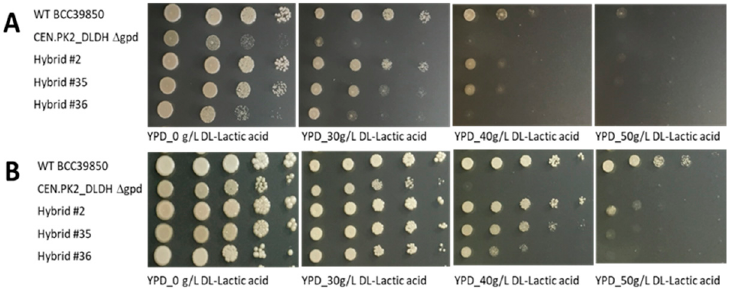
Figure 3. Lactic acid tolerance of S. cerevisiae BCC39850 (wild-type parent), CEN.PK2_DLDH Δ gpd (transgenic parental strain), and progeny hybrid2, hybrid35, and hybrid36. Strains were grown in liquid culture to an initial yeast inoculum OD 600 of 0.5 before spotting on plates. ( A ) Growth at day 1 after spotting on a YPD plate containing 0, 30, 40, 50, and 60 g/L DL-lactic acid and incubation at 30 °C. ( B ). Growth at day 3 after spotting on a YPD plate containing 0, 30, 40, 50, and 60 g/L DL-lactic acid and incubation at 30 °C.